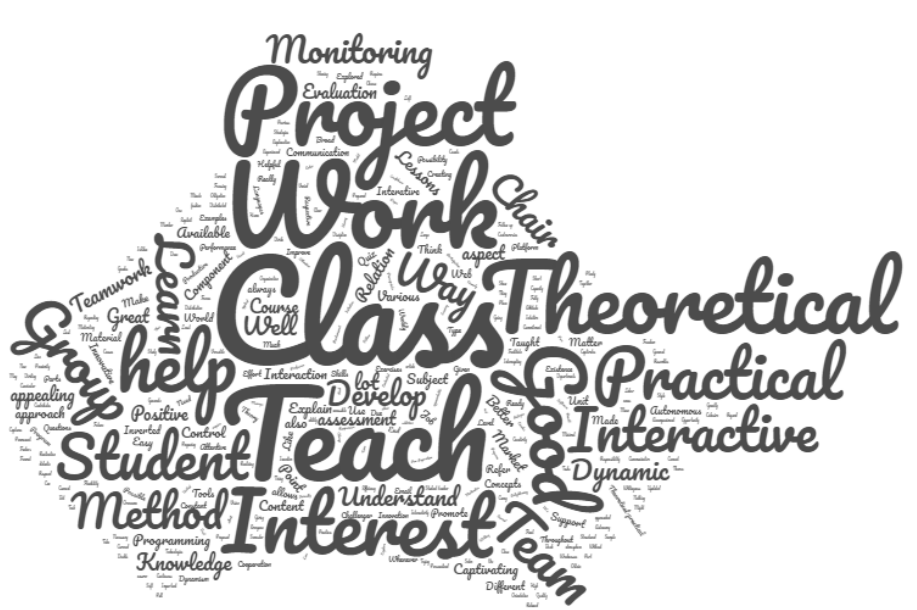
Figure 5. Positive aspects of the